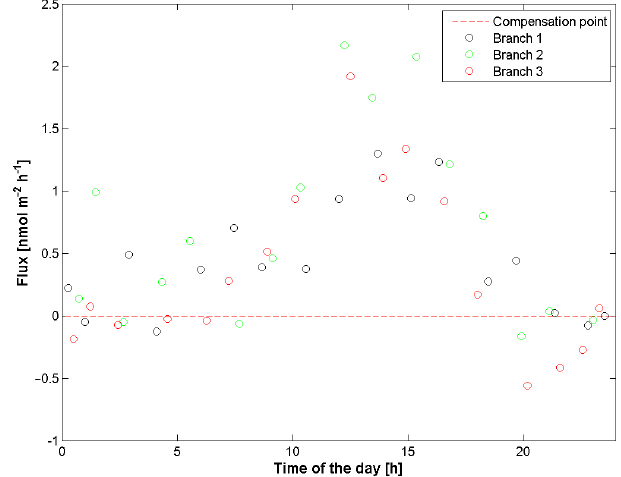
Figure 6. Flux measured as a function of mixing ratio for benzalde- hyde during daytime of the whole branch-level measurement cam- paign. Black triangles represent the period of 25 August–1 Septem- ber, when deposition dominated, and grey dots correspond to the pe- riod of 14–25 August, where mostly emission was measured.